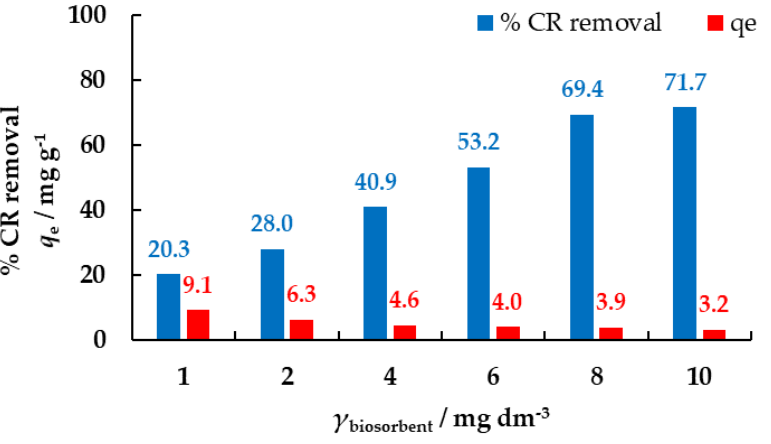
Figure 5. The effect of biosorbent concentration on the biosorption of CR to EP ( γ CR = 50 mg dm − 3 , t = 360 min, pH = 7, T = 298.15 K, v = 150 rpm).